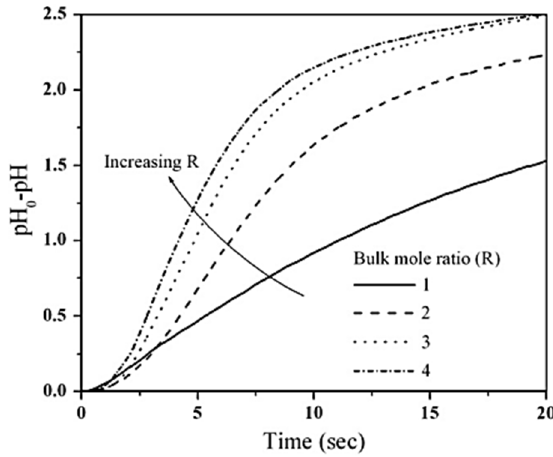
Figure 48. Effect of the monomer mole ratio of HMDI to HMDA (R) on process kinetics (n L /V d = 0.545 kmol/m 3 ). From reference